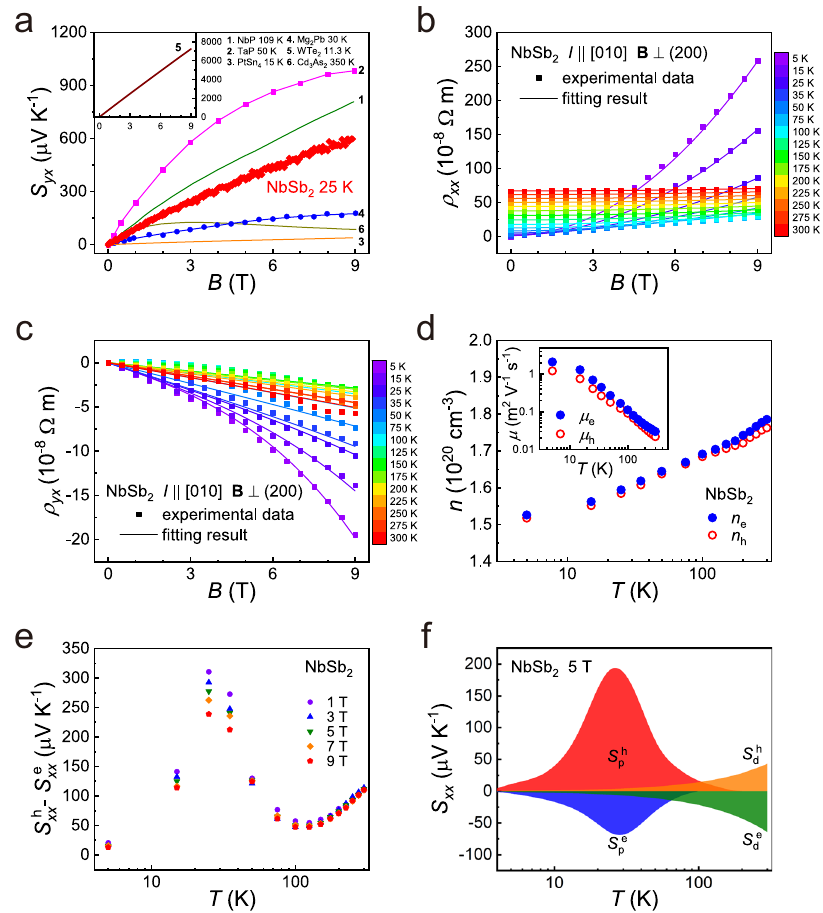
Fig. 4 | Detailed electrical transports for NbSb 2 single crystal. a Nernst ther- mopower ( S yx ) of single-crystalline NbSb 2 as a function of magnetic fi eld B at 25K. The data for PtSn 4 22 , Cd 3 As 2 50 , Mg 2 Pb 26 , NbP 19 , TaP 20 , and WTe 2 27 are included for comparison. b Fitting ofthe transverseresistivity ρ xx ( B ) and c Hallresistivity ρ yx ( B ) of single-crystalline NbSb 2 under different temperatures. The symbols are experi- mental data and the lines are the fi tting curves. In electrical transport measure- ments, the current I is parallel to the [010] direction and the magnetic fi eld B is